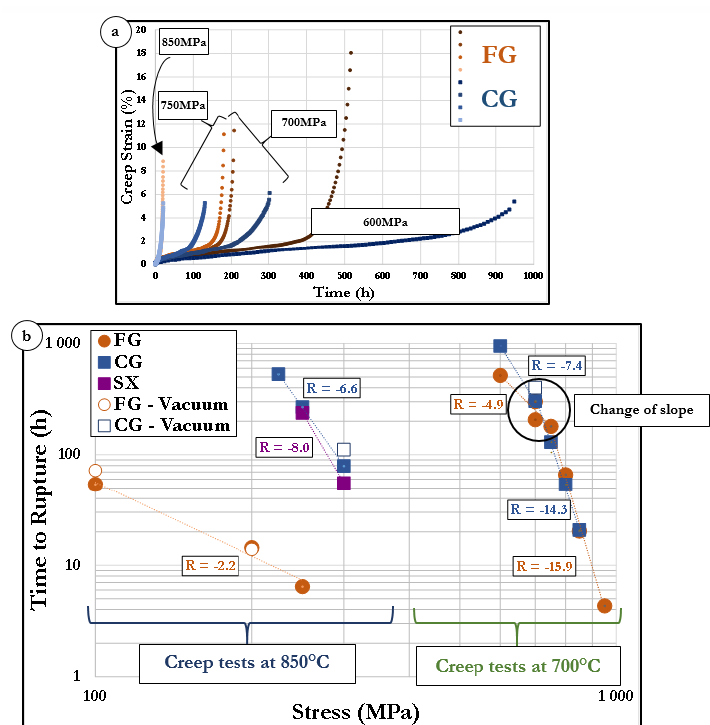
Figure 4. ( a ) Creep behavior at 700 °C for coarse grains and fine grains microstructures; ( b ) Time to rupture as a function of the applied